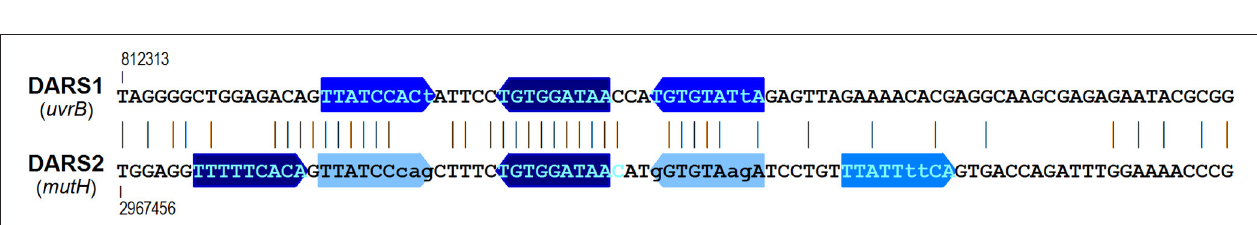
FIGURE 14 | The datA region responsible for DDAH ( datA dependent ATP hydrolysis, Kitagawa et al., 1998; Morigen et al., 2005). The DnaA boxes 2, 7, 3, and IBS are absolutely required for DDAH activity (Kasho et al., 2017). The coordinates are from E. coli K12 (acc.no. U00096.2). IBS: IHF binding site. The color code of the boxes is the same as in Figure 7 . An additional one-misfit box (BoxN) is also indicated.